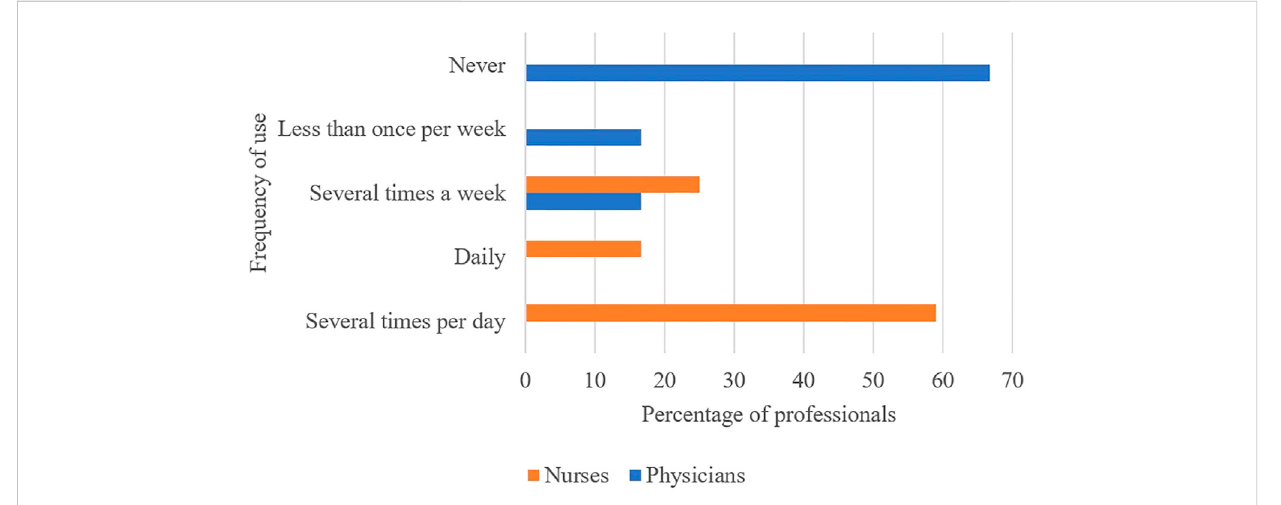
FIGURE 3 Frequency of use of the proper use of medicines tools by the team by